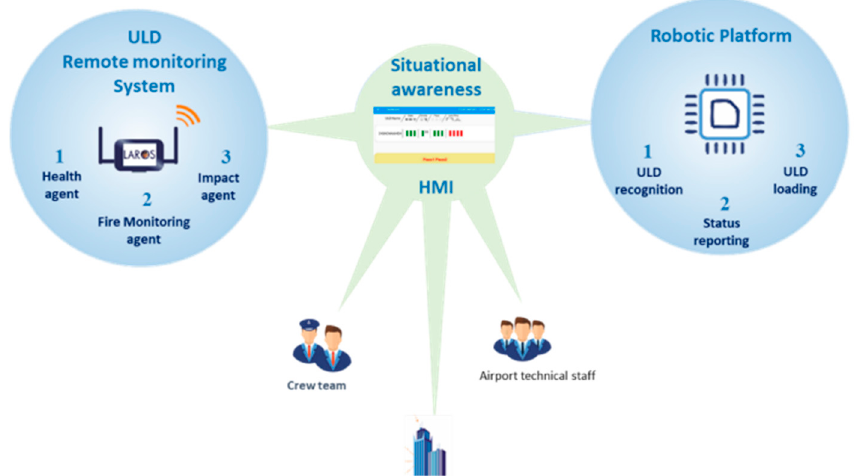
Figure 3. Remote Monitoring System architecture.